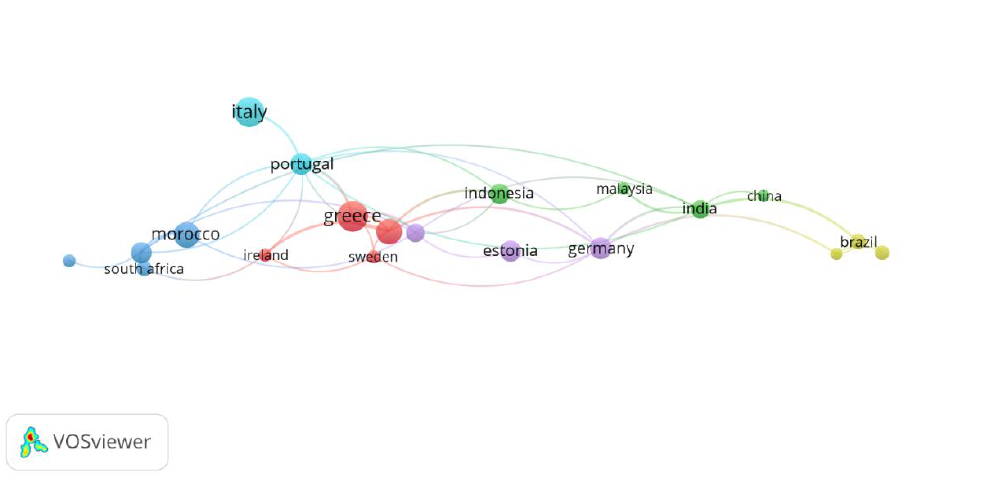
Figure 4: Network Visualisation Citation by Country. Source: Scopus